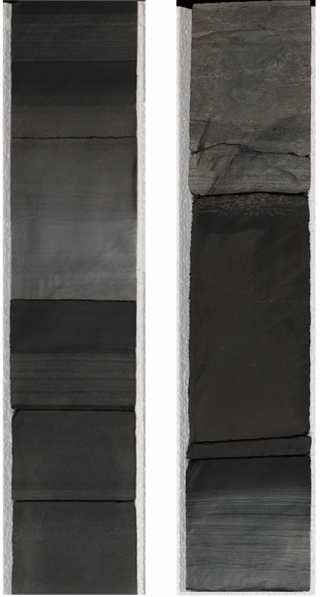
Figure 13. Log plot of the Wolfcamp formation. The correlation track contains log Gamma-ray (green curve) and core gamma ray (black curve). The RESISTIVITY track contains resistivity log. The COMBINED track contains formation lithology fractional volumes determined by volumetric log analyses. The P-wave velocity track contains sonic P-wave velocity (red curve) and ultrasonic P-wave velocity (purple discrete data points). The S-wave velocity track contains sonic S-wave velocity (red curve) and ultrasonic S-wave velocity (blue discrete data points). The RhoB track contains log measured bulk density (red curve) and core measured bulk density (blue discrete data). Depths in the depth track are only to indicate depth scale; actual depths are not available for publication.